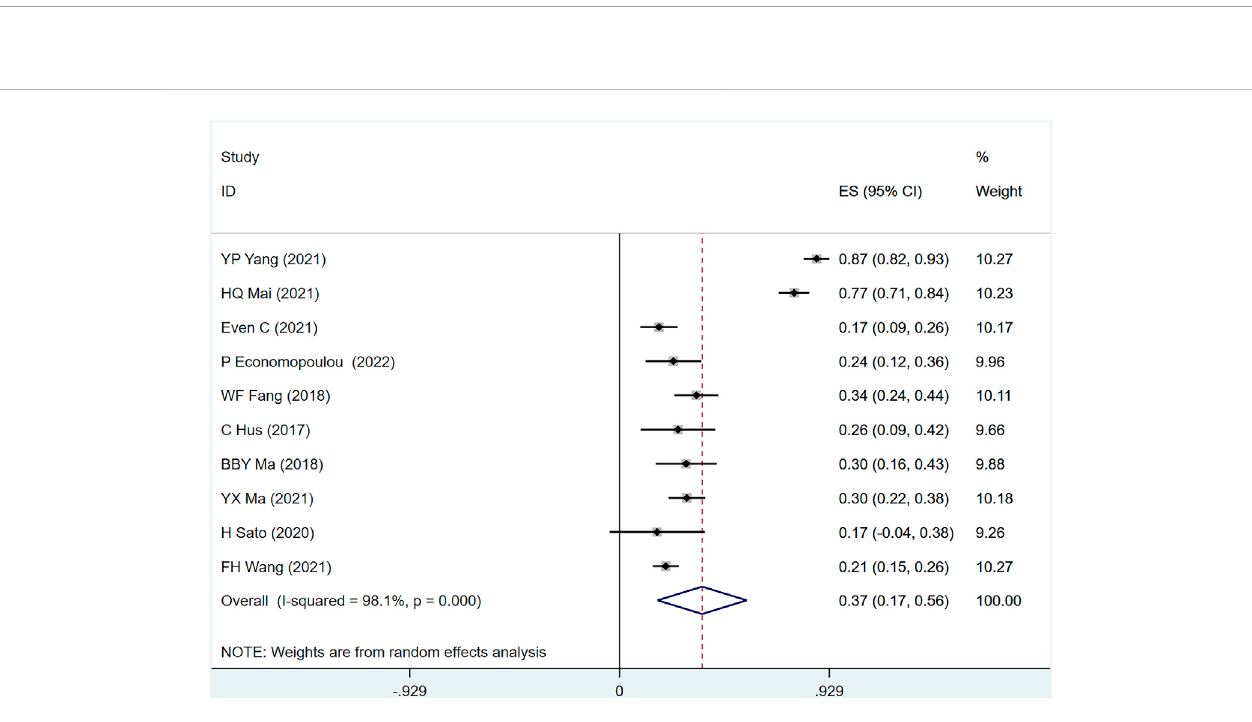
FIGURE 5 Estimated ORR proportion (95% CI) of patients with metastatic/recurrent nasopharyngeal carcinoma after PD-1 treatment forest plot — single arm